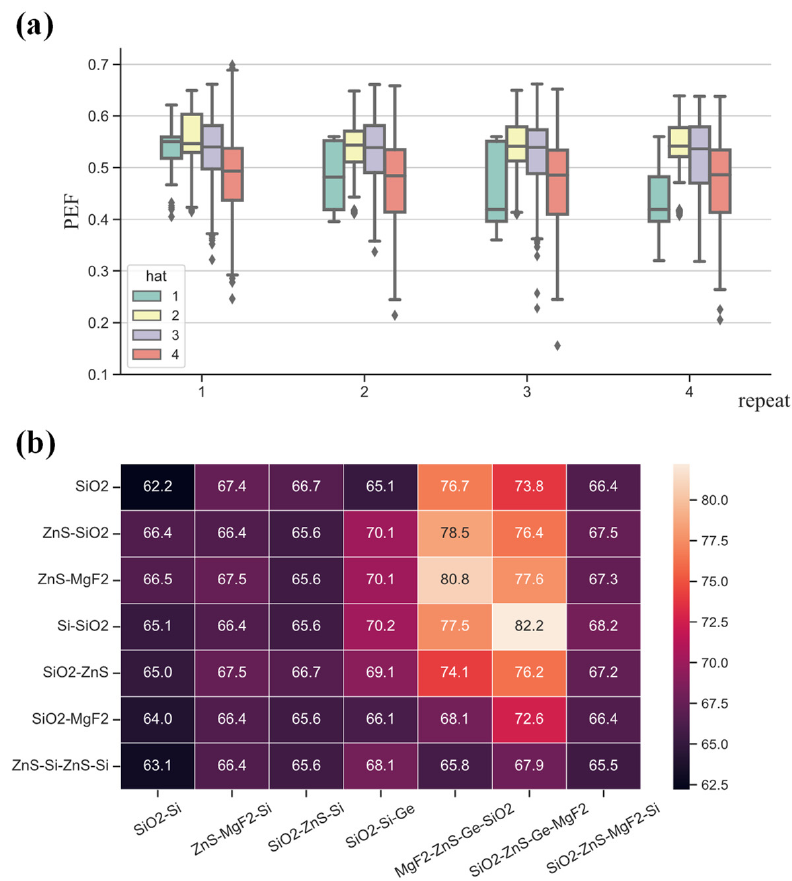
Figure 4. ( a ) The boxplot of values of PEF corresponding to structures with different hats and repetition of periodic materials. ( b ) The heatmap of different FP substructures and hat substructures.